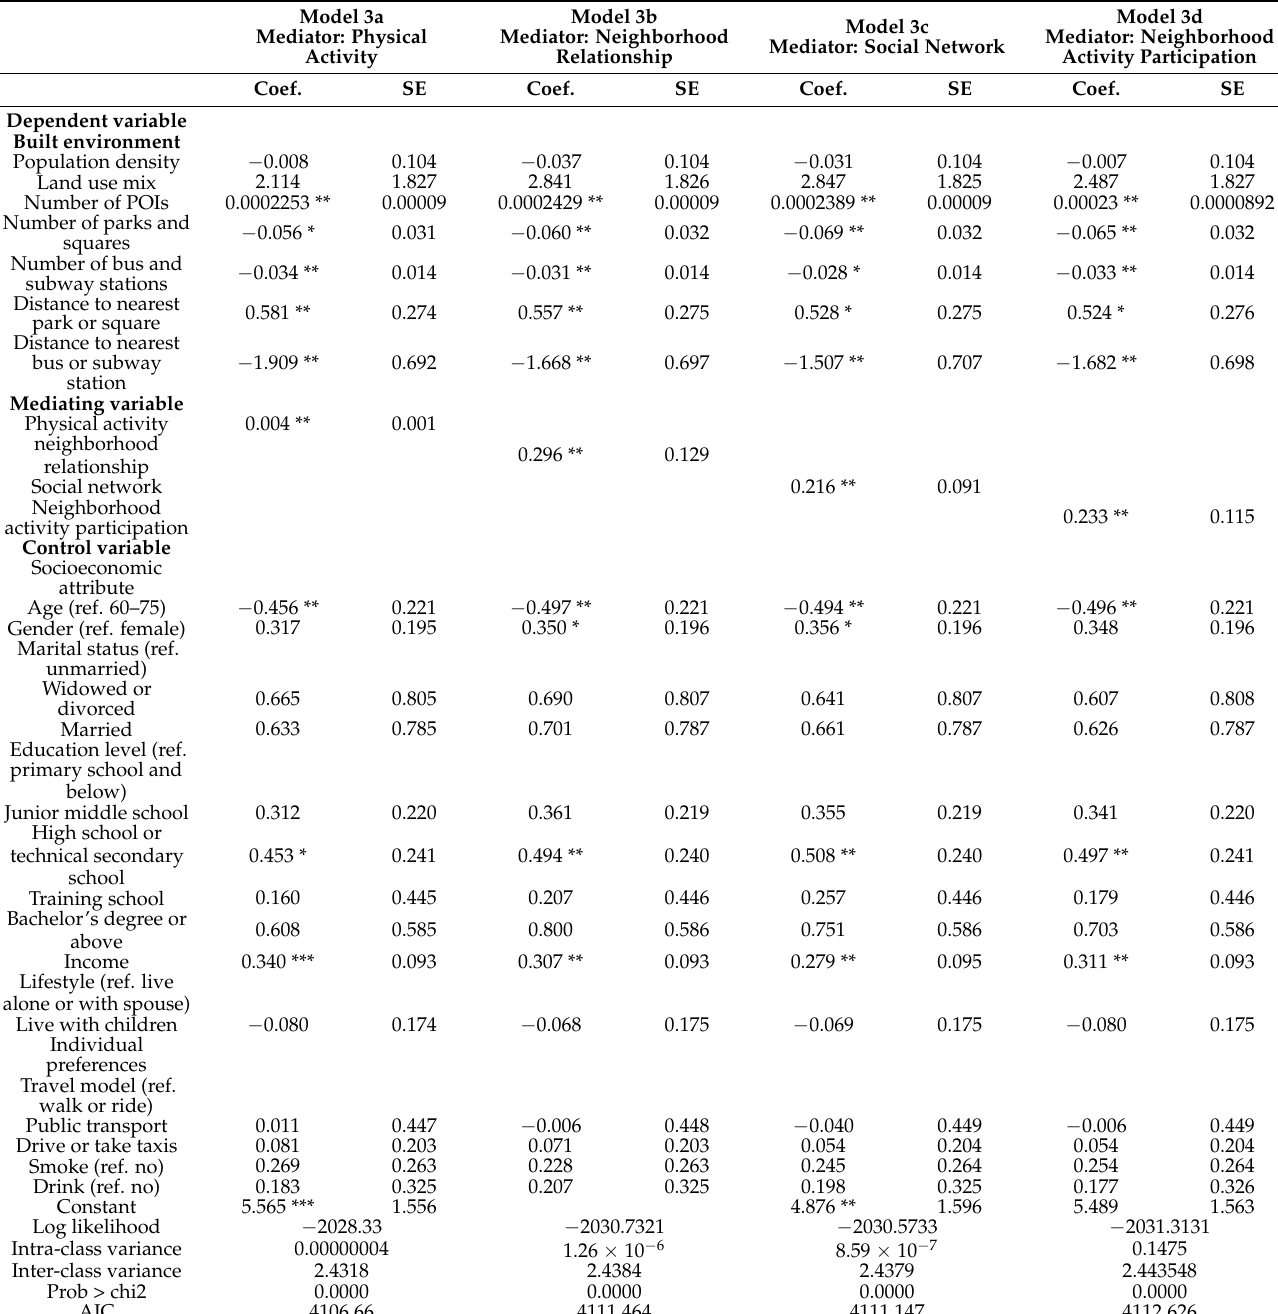
Table 4. Results of physical health relations: the mediating effect of the four mediators. Model 3a Model 3b Model 3d Model 3c Mediator: Physical Mediator: Neighborhood Mediator: Neighborhood Mediator: Social Network Activity Relationship Activity Participation Coef. SE Coef. Coef.